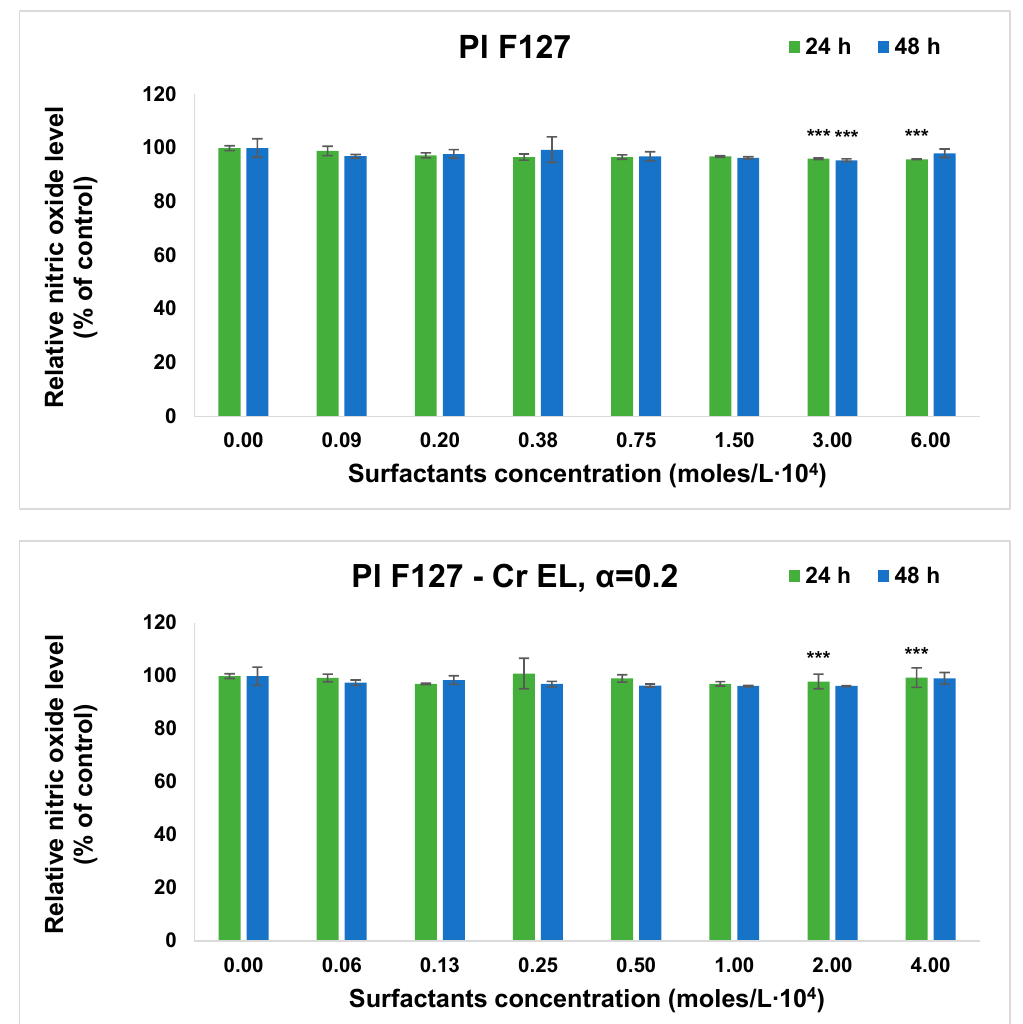
Figure 7. NO release measured by Griess assay after 24 and 48 h of cell growth in the presence of surfactants. Results are presented as mean ± standard deviation of three independent experiments (** p < 0.01 and *** p < 0.001 compared with control).